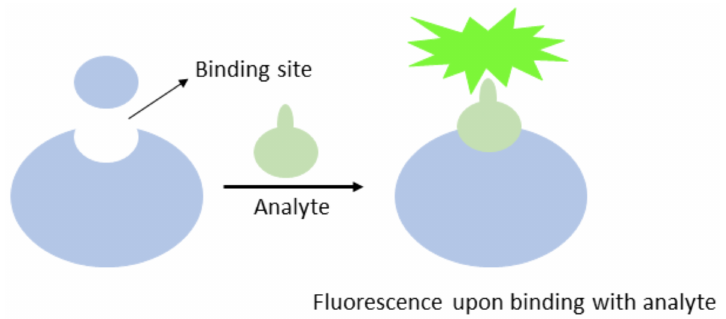
Figure 1. Schematic representation depicting the mechanism of action of chemosensor detecting an analyte in the solution and giving rise to a detectable